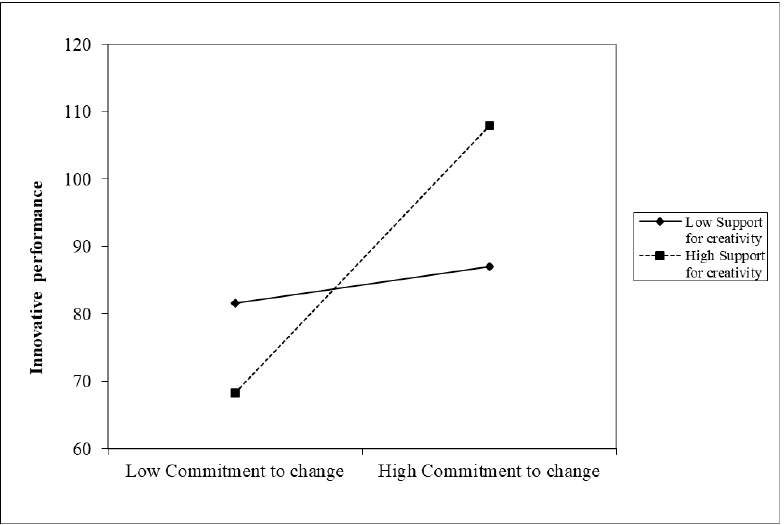
Figure 3. Interaction effects of support for creativity on innovative behavior (performance).